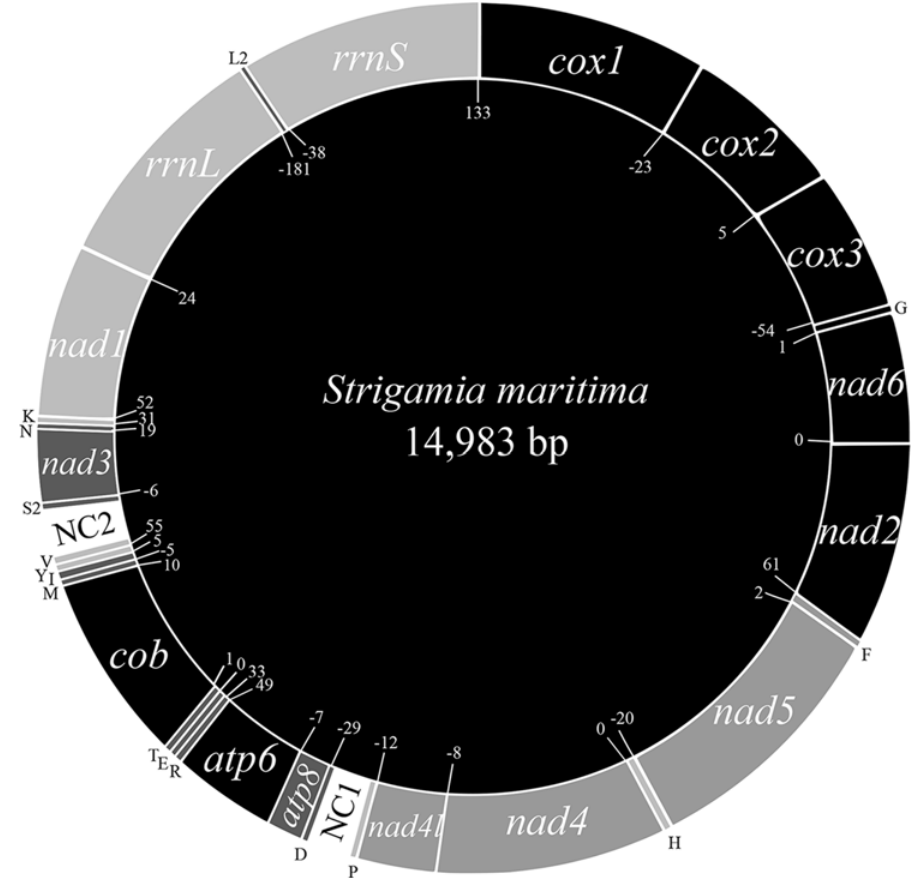
Fig 1. Overview of the mitochondrial genome of Strigamia maritima (Myriapoda: Chilopoda), genes not drawn to scale. Numbers inside the circle show intergenic spaces (positive values) or intergenic overlaps (negative values). Protein-coding genes are denoted by three letter abbreviations, ribosomal genes denoted by four letter abbreviations. tRNAs are indicated by single uppercase